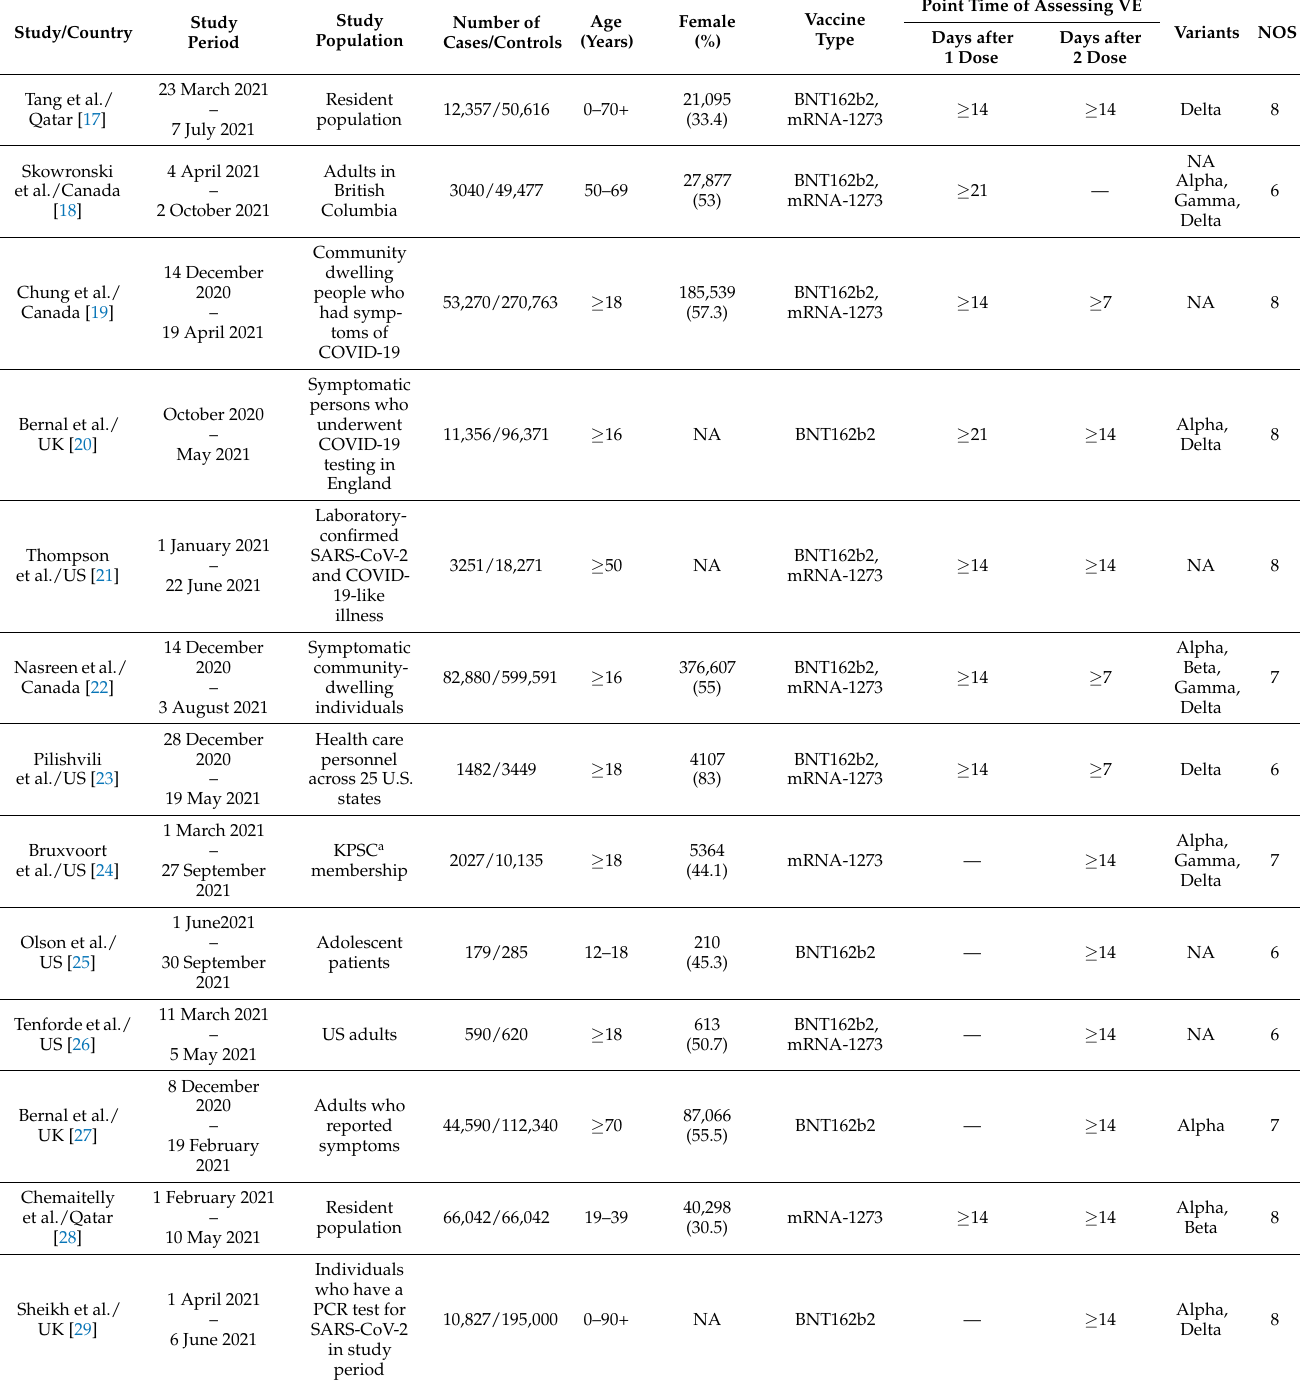
Table 1. Main characteristics of the included